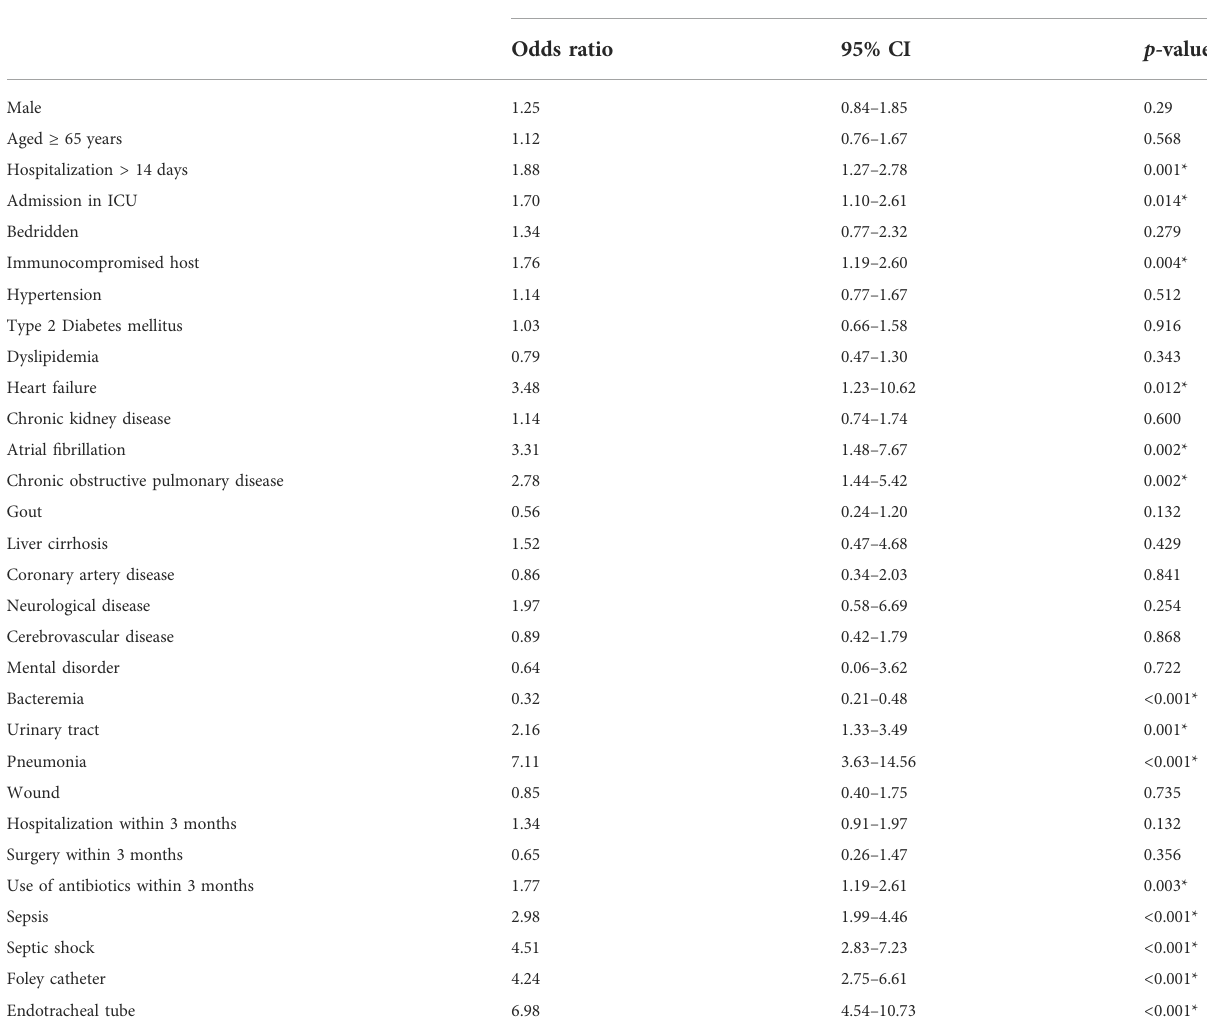
TABLE 2 | Association between factors and mortality using univariate analysis.